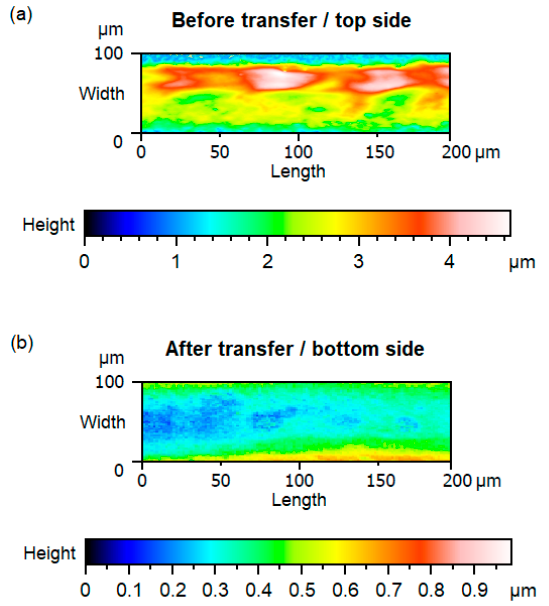
Figure 11. False color images of the sample height, measured by confocal microscopy before ( a ) and after ( b ) the transfer process. For the investigation, a GenesInk-printed conductive path was used.